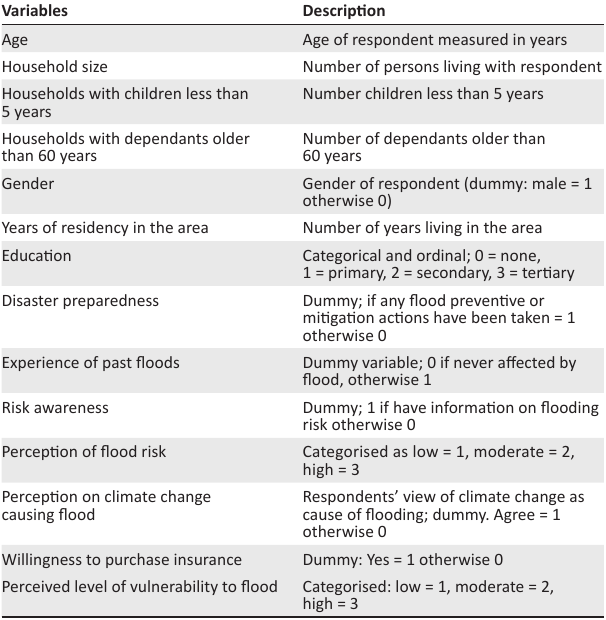
TABLE 2: Definition of variables used in